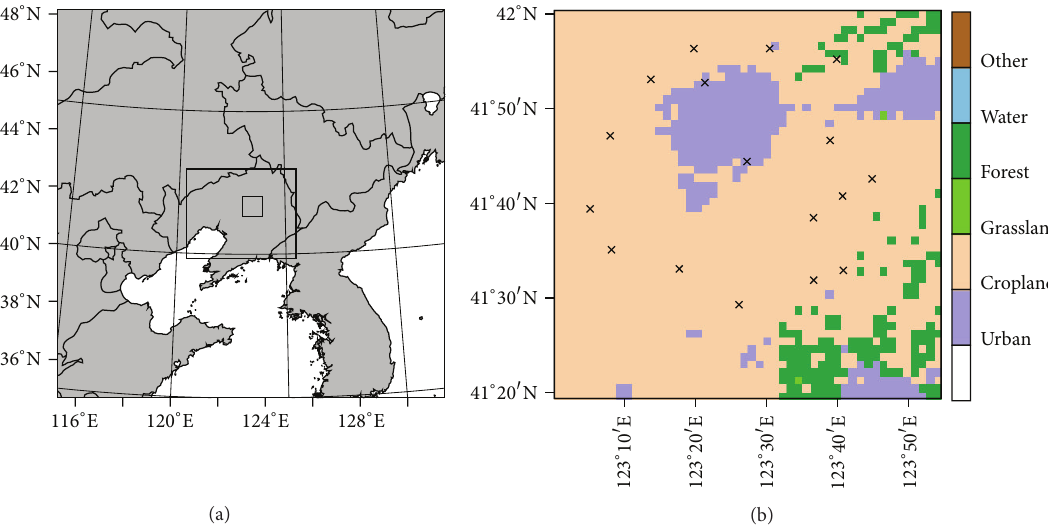
Figure 1: Nested computational domains and the land use category of the innermost domain in the WRF model simulation: (a) nested computational domains in the WRF model simulation; (b) the land use category of the innermost domain of the WRF model. Crosses show the location of the meteorological observatories.